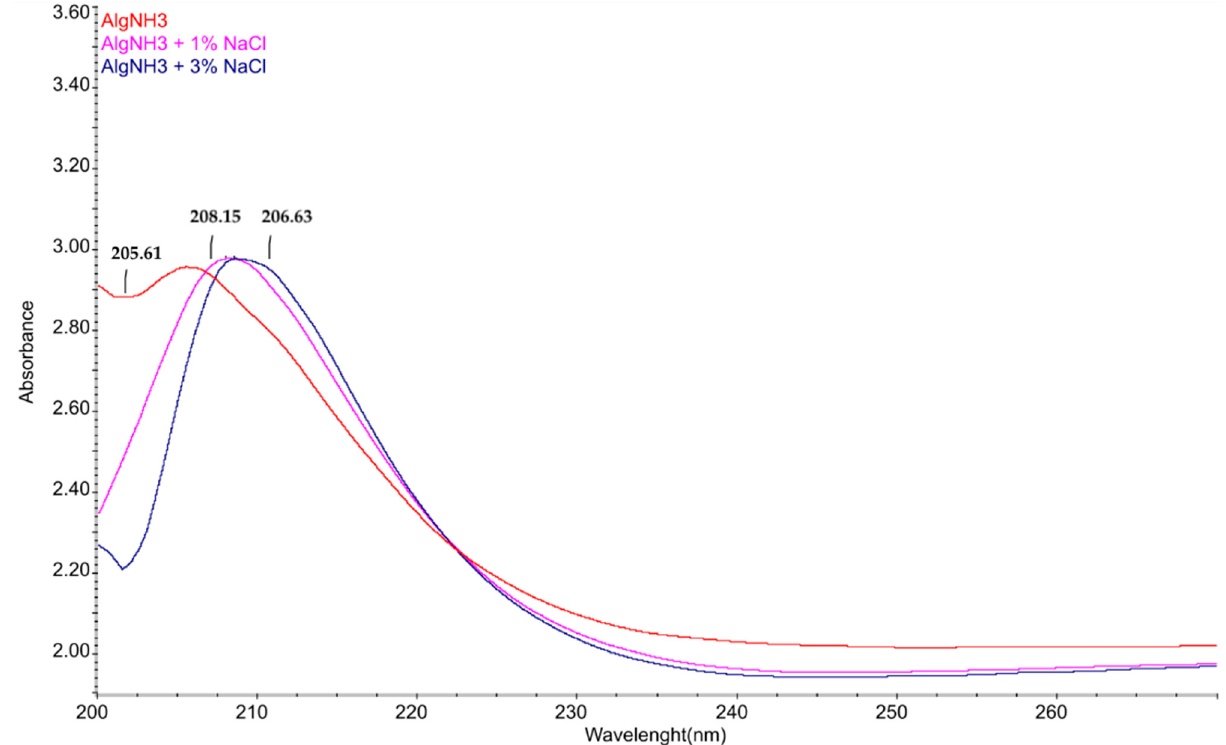
Figure 5. The UV–Vis spectra of the ammonium alginate, obtained as a result of ammonia vapour interaction with alginic acid. Table 4. The size of particles (Z-Ave) and the polydispersity index (PDI) of diluted solutions of sodium alginate and ammonium alginate in the presence of